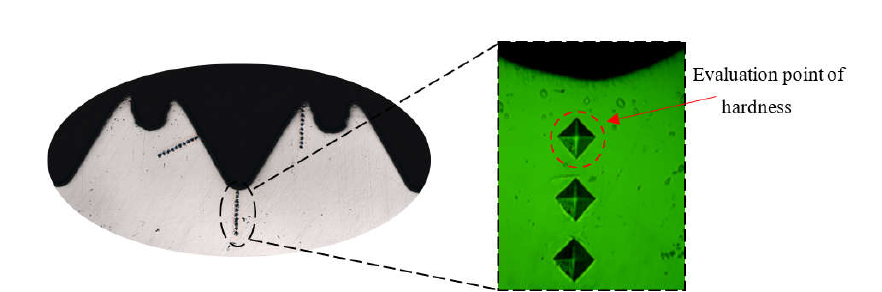
Figure 12. Hardness evaluation point of thread